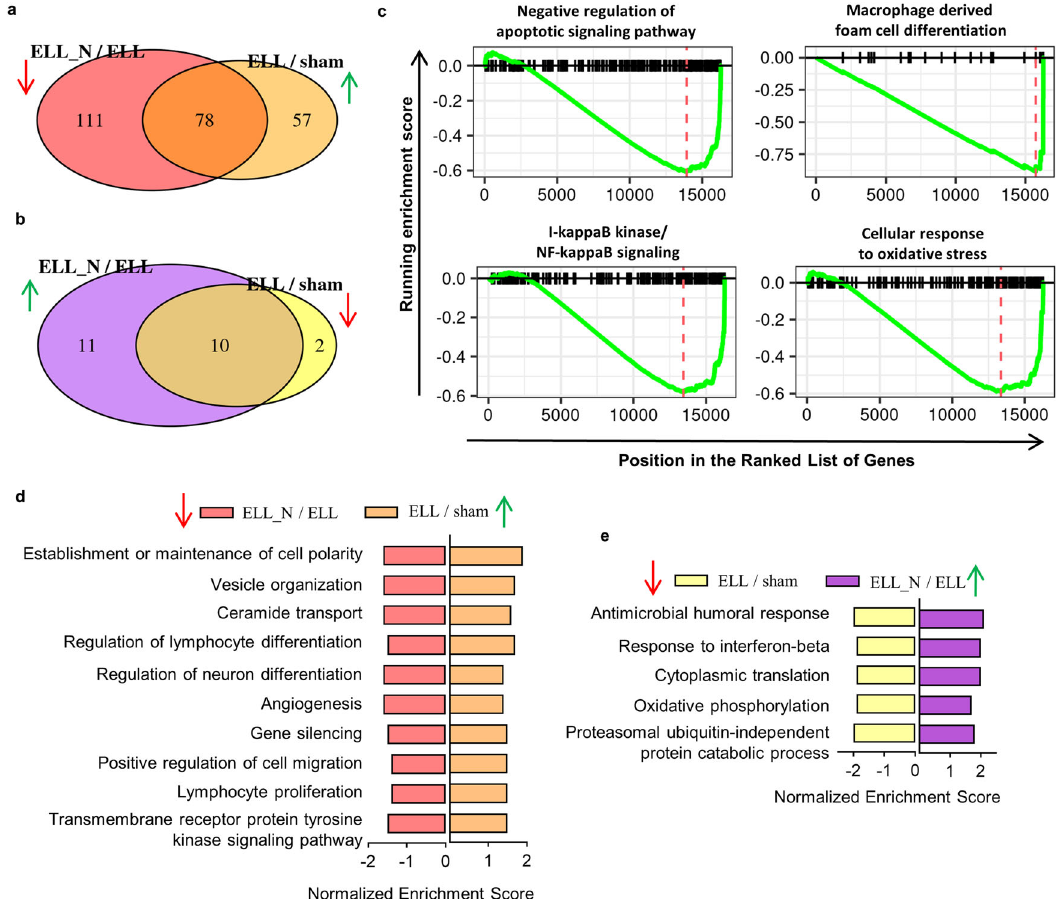
Fig. 2 Niclosamide fi nely reverses transcriptomic changes caused by endometriosis-like lesions (ELL) to peritoneal macrophages. a Venn diagram shows the overlaps of enriched GSEA terms of biological processes between those enhanced in by ELL (ELL/sham) and those reduced by niclosamide (ELL_N/ELL). b Similar to ( a ) but shows the overlaps between enriched terms of those down-regulated in ELL (ELL/sham) and up-regulated by niclosamide (ELL_N/ELL). c Enriched GSEA terms of biological processes that were reduced within the ELL_N group compared to the sham group. d Representative GSEA terms that were enhanced by ELL (ELL/sham) and were decreased by niclosamide (ELL_N/ELL). e Representative GSEA terms that were inhibited by ELL (ELL/sham) and were reversed by niclosamide